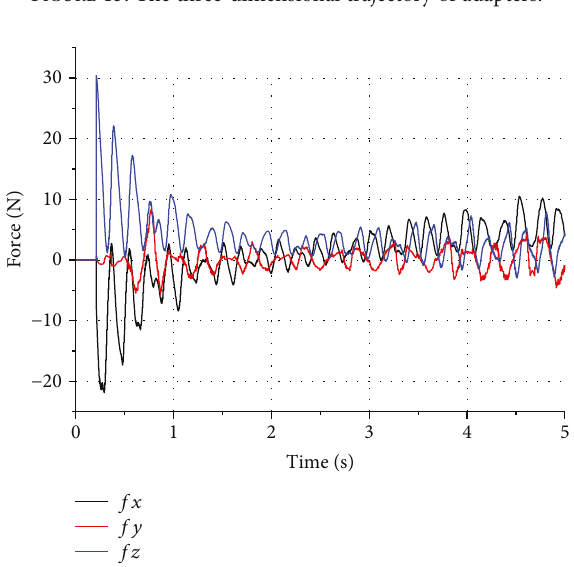
Figure 15: The three-dimensional trajectory of adapters.